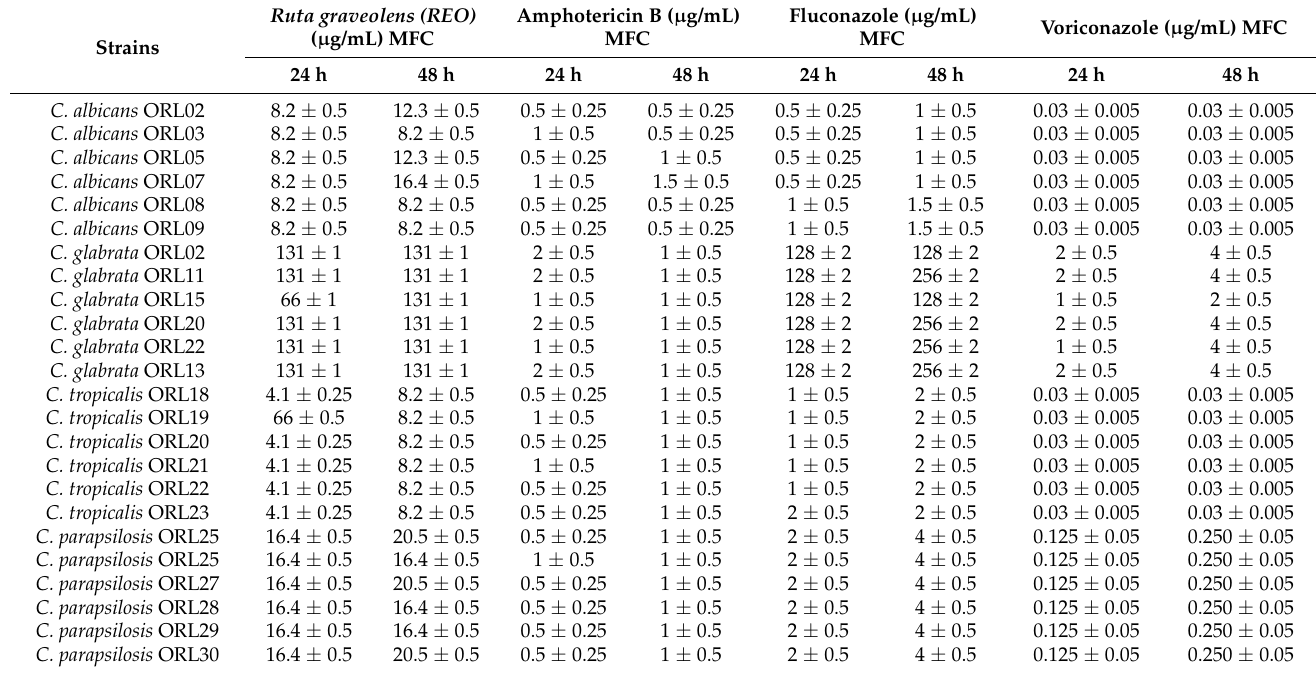
Table 2. In vitro susceptibility of Candida spp. isolates to Ruta graveolens essential oil and antifungal drugs. Ruta graveolens (REO) Amphotericin B ( µ g/mL) ( µ g/mL) MFC MFC Strains C. albicans